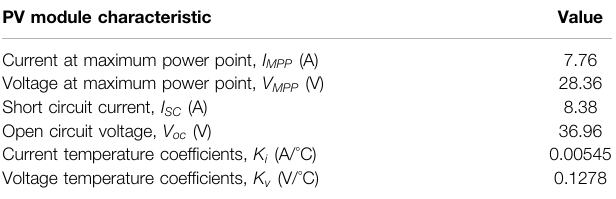
TABLE 2 | Characteristics of the photovoltaic (PV)